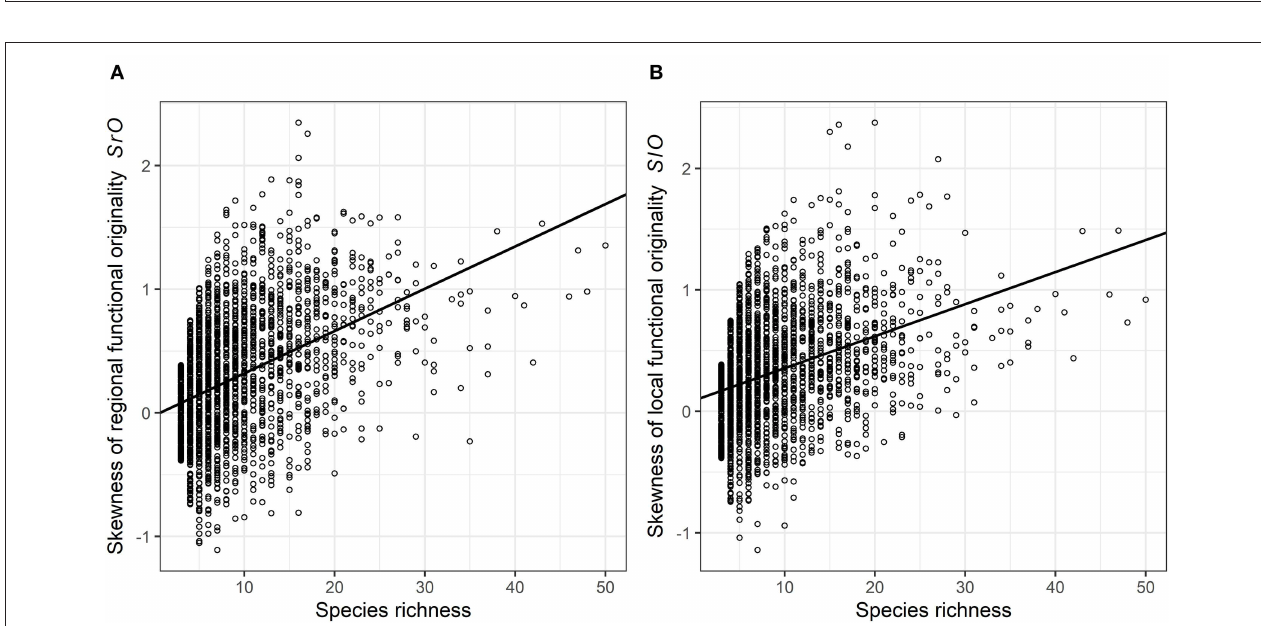
FIGURE 4 | The skewness of the (A) regional and (B) local functional originality according to the species richness (SR) in each species plot of the complete dataset. One data point represents one plot. The black curve represents the estimated trend retrieved from the skewness of generalized mixed linear models.